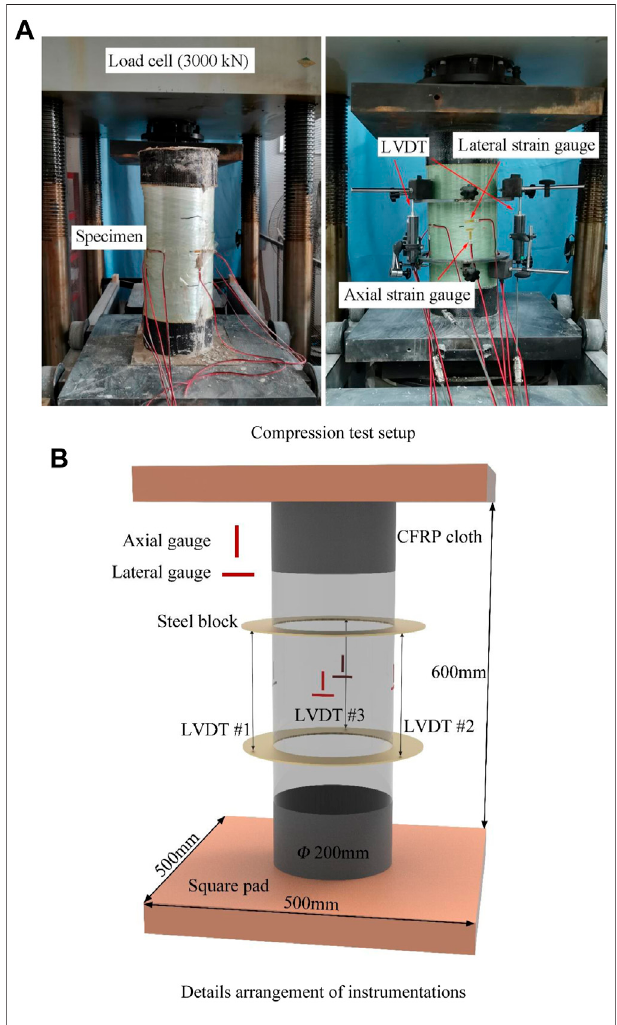
FIGURE3|(A) Compression testsetupand (B) detailedarrangementof